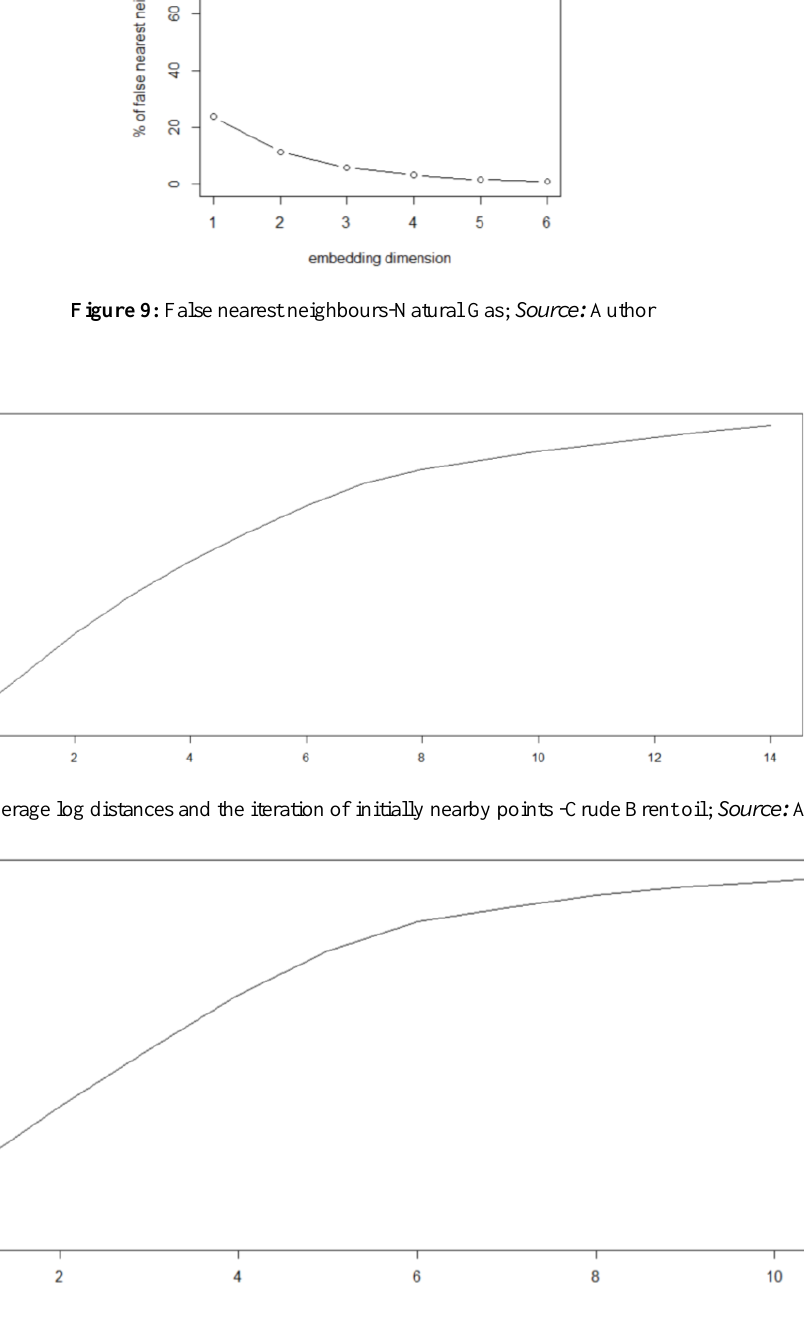
Figure 11: Average log distances and the iteration of initially nearby points-Global food index; Source: